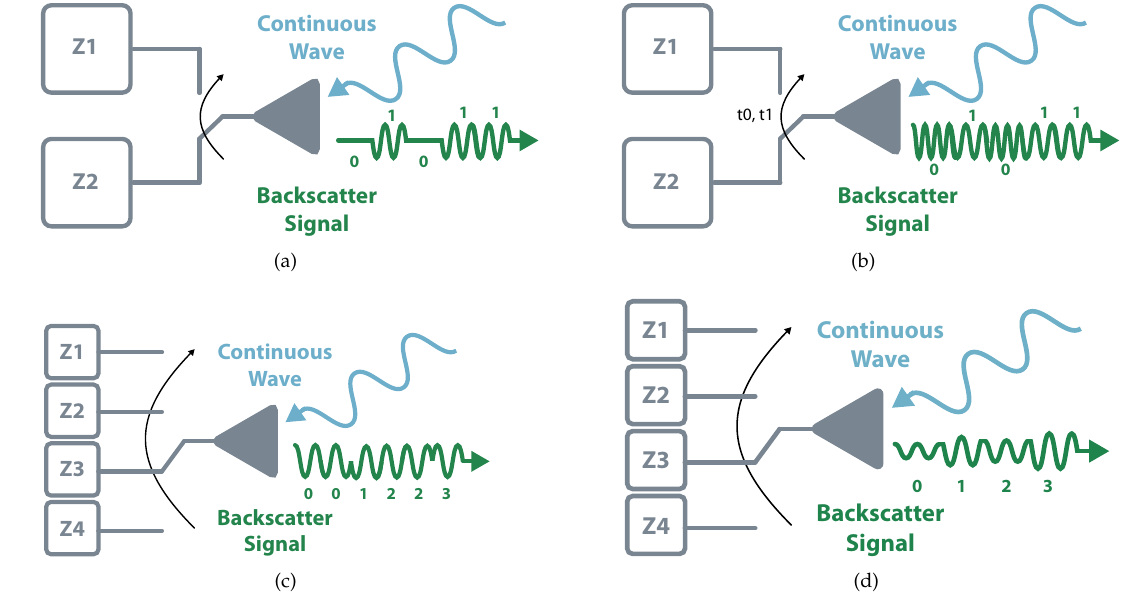
Figure 4. Modulation Schemes. ( a ) On-Off Keying. ( b ) Frequency Shift Keying. ( c ) Phase Shift Keying. ( d ) Quadrature Amplitude